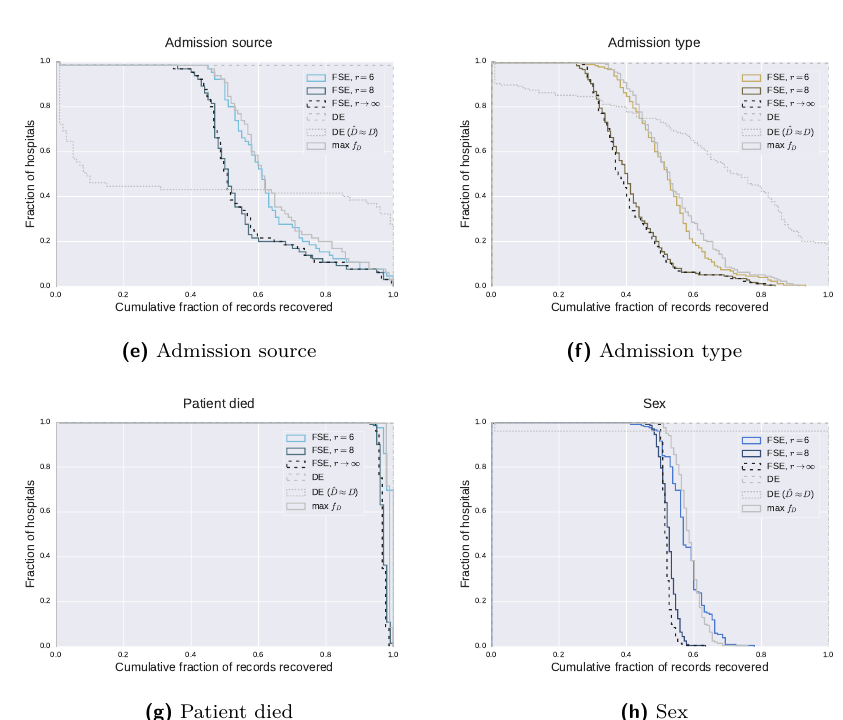
Figure 7: Our experimental results by attribute: complementary cumulative distributions (continued from previous page and continued on next